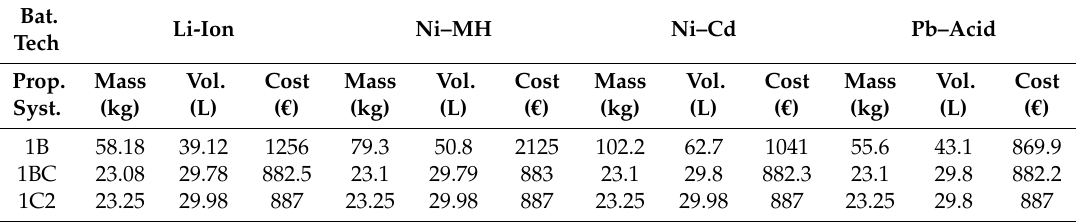
Table 7. Mass, volume, and cost of the architectures selected from each group, with the ECE-15 driving profile, and variation in the state-of-charge of the battery of 75%, for lithium-ion, Pb–acid, nickel–metal hydride, and nickel–cadmium.